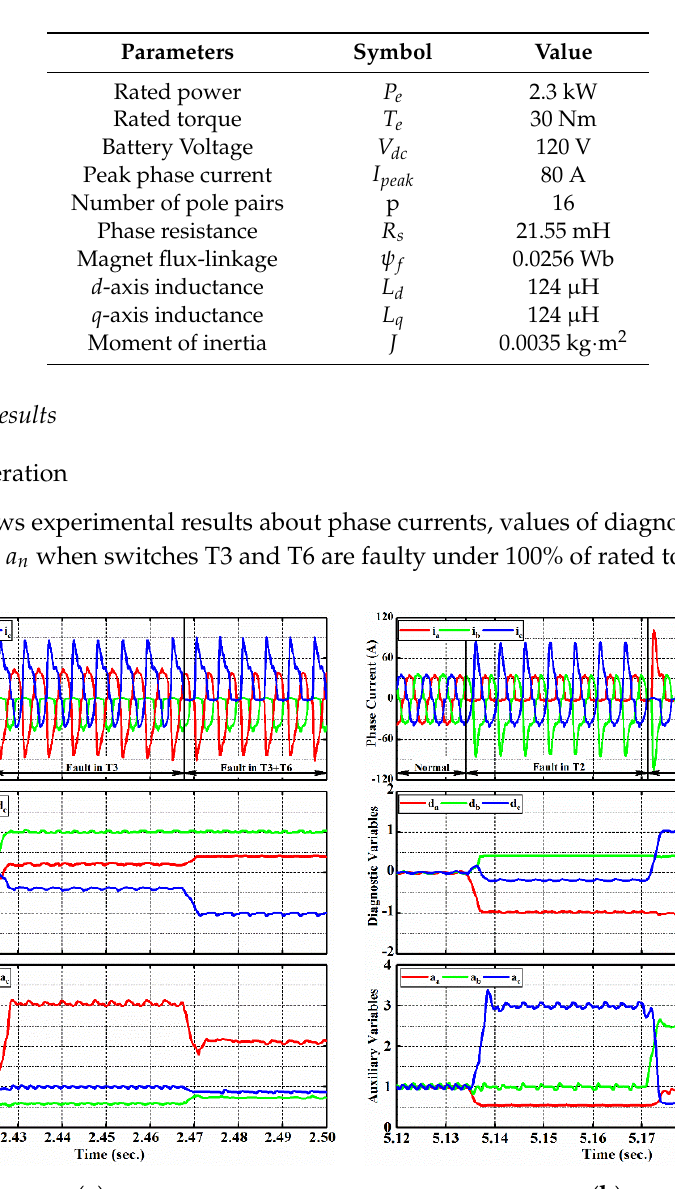
Table 3. Parameters of used PMSM.